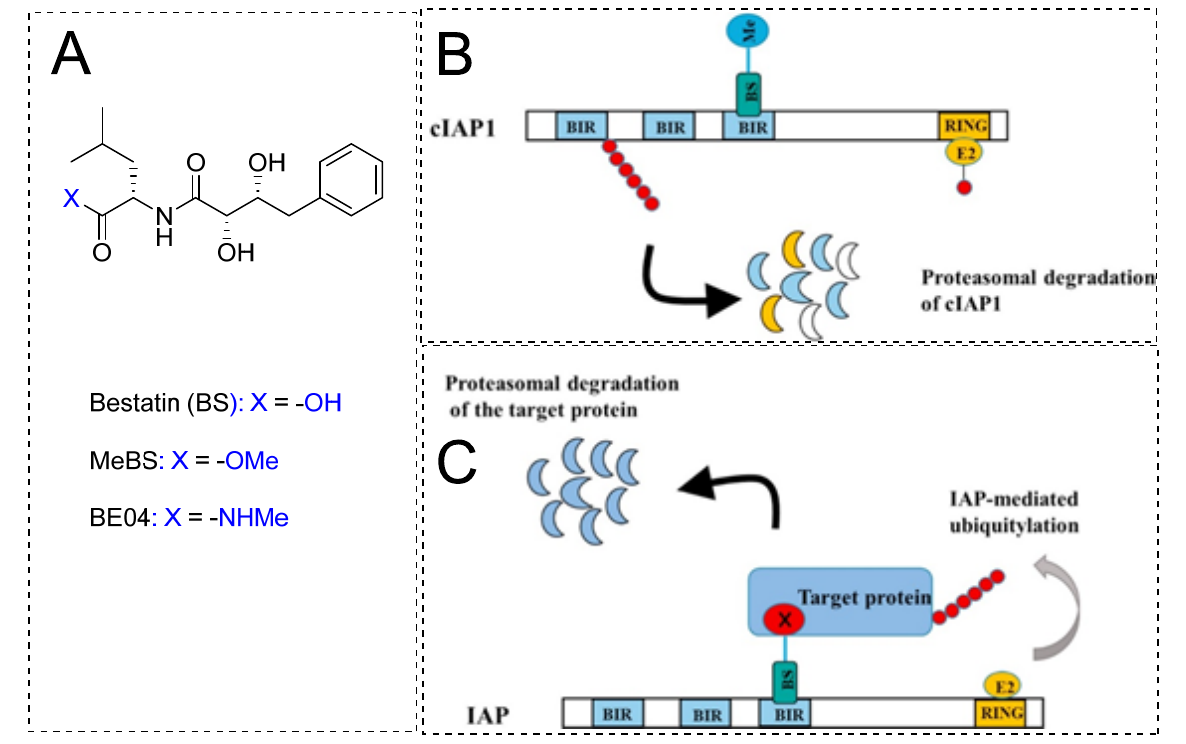
Figure 12. ( A ) Molecular structure of bestatin and its derivatives. ( B ) Reported degradation mecha- nism of cIAP. ( C ) Illustration of degradation associated with SNIPERs. ( B , C ) were reproduced with permission from Lin et al. [50] Copyright 2021 Elsevier.